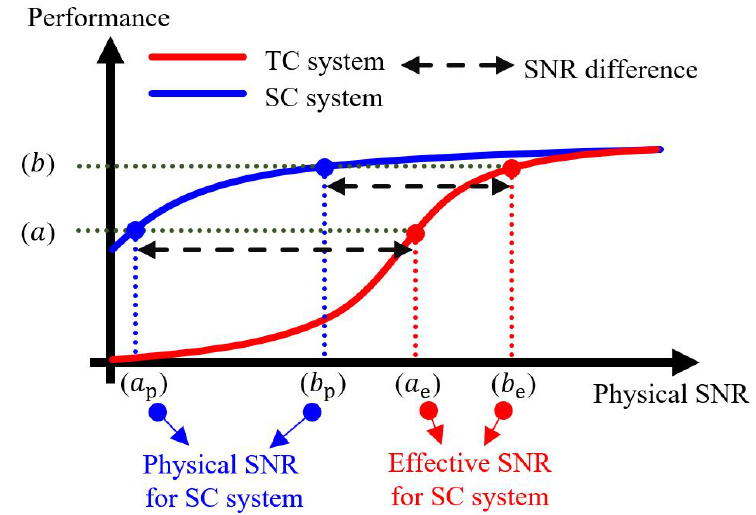
Figure 2. An illustration of correspondence of the performance of an SC system and a TC system to explain the physical SNR and the effective SNR for an SC